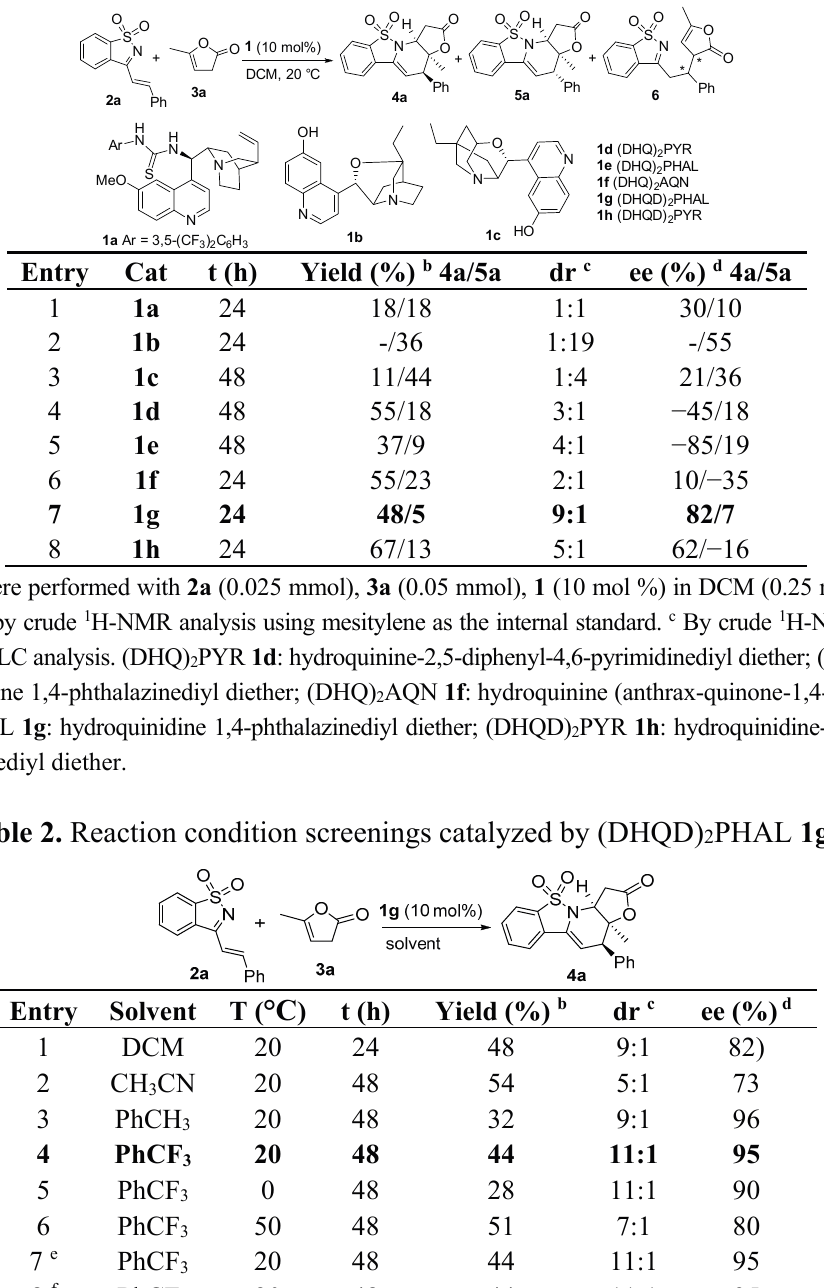
Table 1. Initial catalyst screening studies on [4+2] cycloaddition of 3-styryl-1,2- benzoisothiazole-1,1-dioxide 2a and α -angelica lactone 3a a .